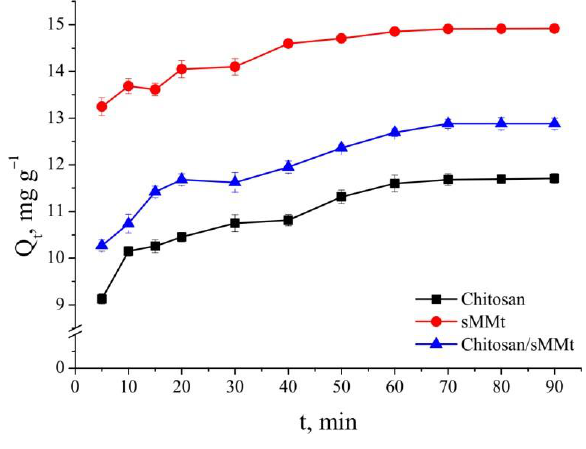
Fig. 8 Effect of adsorption contact time toward the adsorption capacity of chitosan, sMMt, and chitosan/sMMt